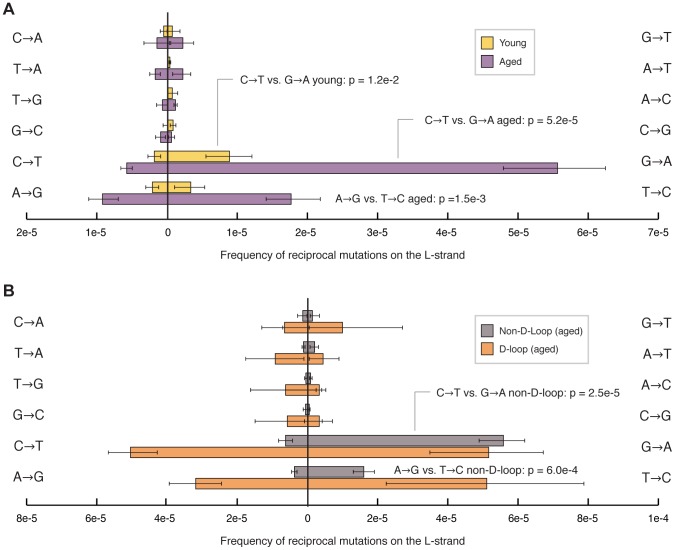
Transition mutations show a pronounced strand bias in their occurrence.(A) Comparison of frequencies of reciprocal mutation types on the L-strand for both young (yellow) and aged (purple) sample groups shows that young individuals exhibit a strand bias in the occurrence of G→A/C→T mutations. Aged samples exhibit an even stronger bias in both G→A/C→T and T→C/A→G mutations. No strand bias was observed for transversion mutations. (B) Comparison of frequencies of reciprocal mutation types on the L-strand from aged individuals shows no significant strand bias in the D-loop (bp 16,025-576) region (grey) of mtDNA, while the non-D-loop portion (bp 577–16,024) (orange) of the genome from the same aged samples exhibits a strong strand bias. Frequencies were calculated by dividing the number of mutations of each type by the number times the wild-type base of each mutation type was sequenced. Error bars represent one standard deviation. Significance was tested using the two-tailed t-test.